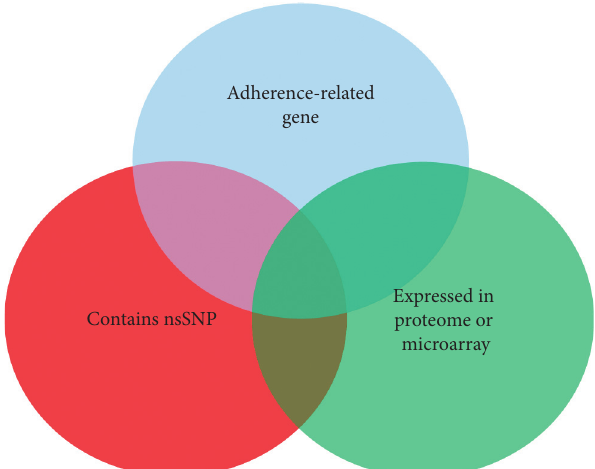
Figure 1: Gene selection process. The whole genome of SS17 was fully annotated through RAST and manual annotations [5]. Adherence genes were compared against a previously performed proteome and comparison of the genes that contained nsSNPs compared to a non-SS isolate EDL933. Any nonfimbrial adhesins matching two of these three criteria were